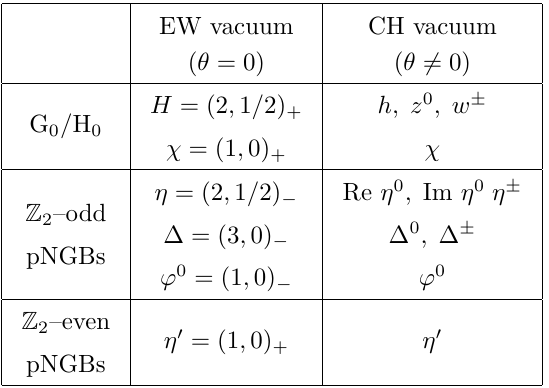
The pNGBs in the template SU(6)/Sp(6) model in the EW-preserving alignment, characterized by their (SU(2) L , U (1) Y ) Z quantum numbers, and in the CH vacuum. Note that √ 2 H = ( w + , ( h + i z 0 ) / 2) T , where w ± , z 0 are the Goldstones eaten by the W ± and Z